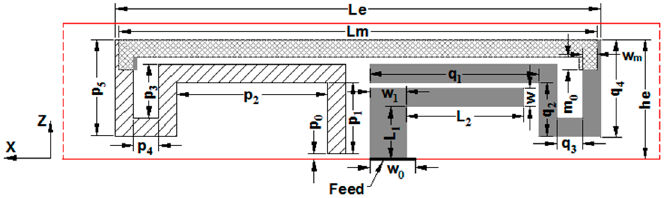
Figure 2. Planar view of the antenna element.